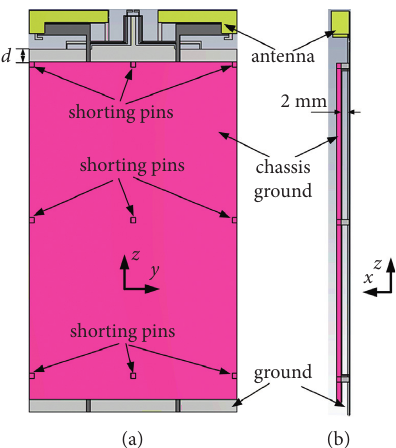
Figure 7: Installation position of the chassis ground plane. (a) Front view. (b) Side view.